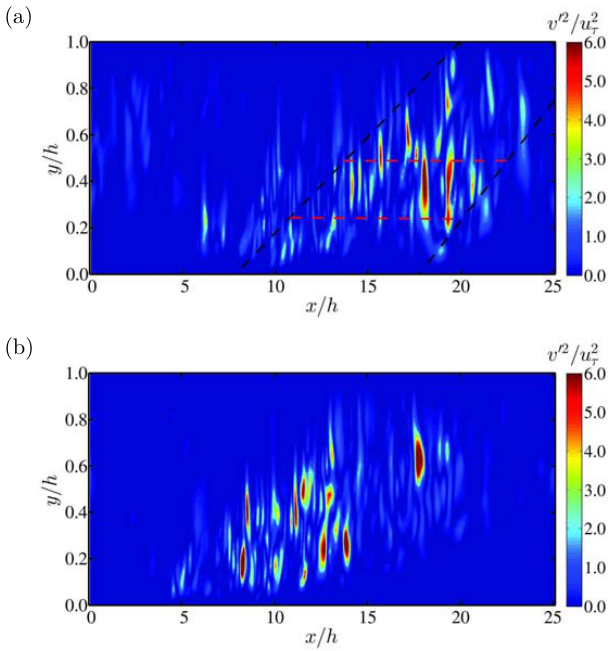
Figure 11. Instantaneous contours of v (cid:48) 2 at the mid-spanwise plane (not to scale, Re τ = 180). Please refer to Fig. 2 for the definition of the spanwise plane. The black-dashed lines denote the approxi- mate boundary of the turbulent bands at different vertical locations and the red-dashed lines represent the width of the turbulent bands observed in the x – z plane in Fig. 10. (a) Ri τ = 120, z/h = 2 π , (b) Ri τ = 240, z/h = 2 π .